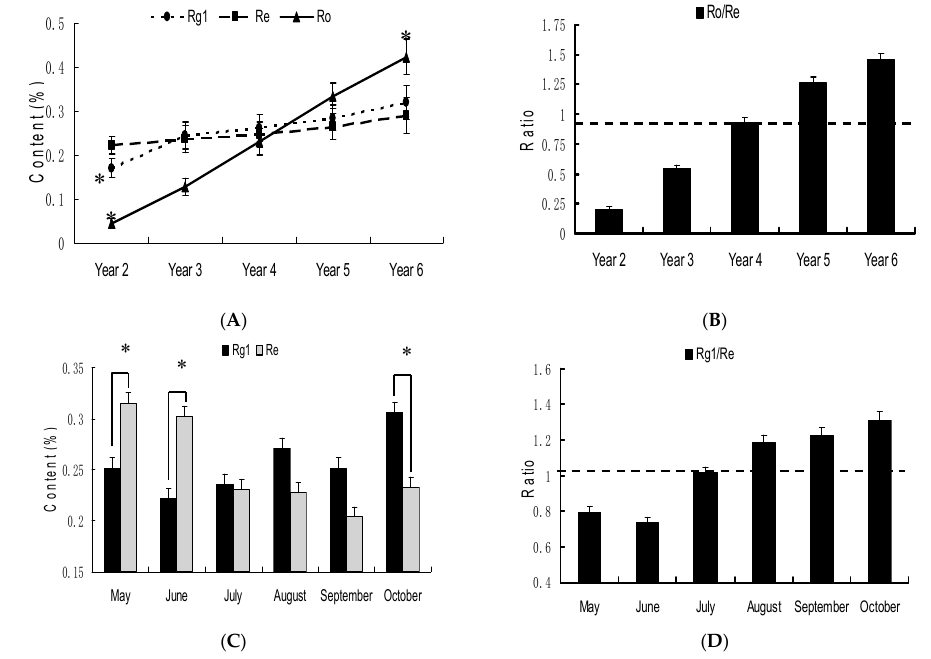
Figure 3. ( A ) Changes in the ginsenoside Rg 1 , Re and Ro contents in the Panax ginseng root according to the cultivation year. * p < 0.05, one-way ANOVA (compared with the Year 4); ( B ) Ratio of